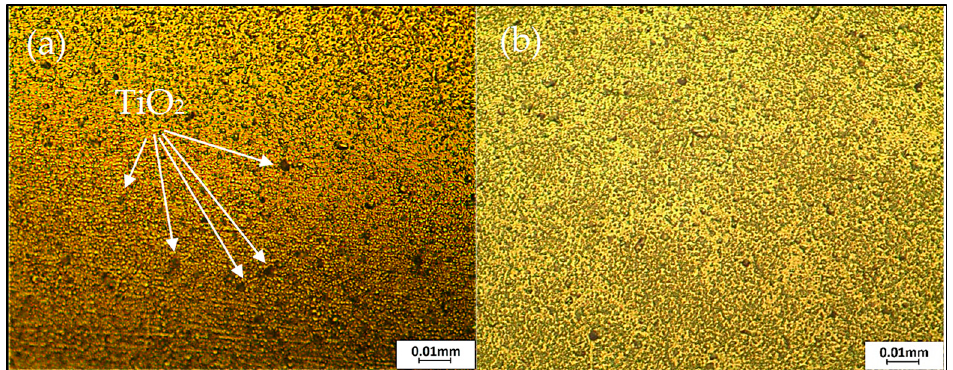
Figure 10. Microstructures (50×) of ( a ) FSPed recycled AA 6063/TiO 2 and ( b ) FSPed recycled AA 6063 produced at 2442 rpm and 50 mm/min.